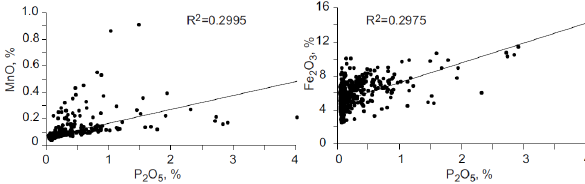
Fig. 4. Scatter plots of P 2 O 5 versus MnO, and P 2 O 5 versus Fe 2 O 3 concentrations for